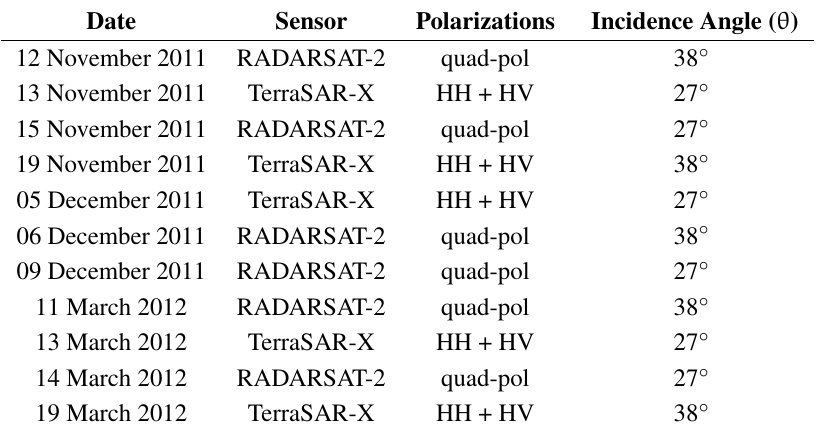
Table 2. Acquisition dates and characteristics of SAR